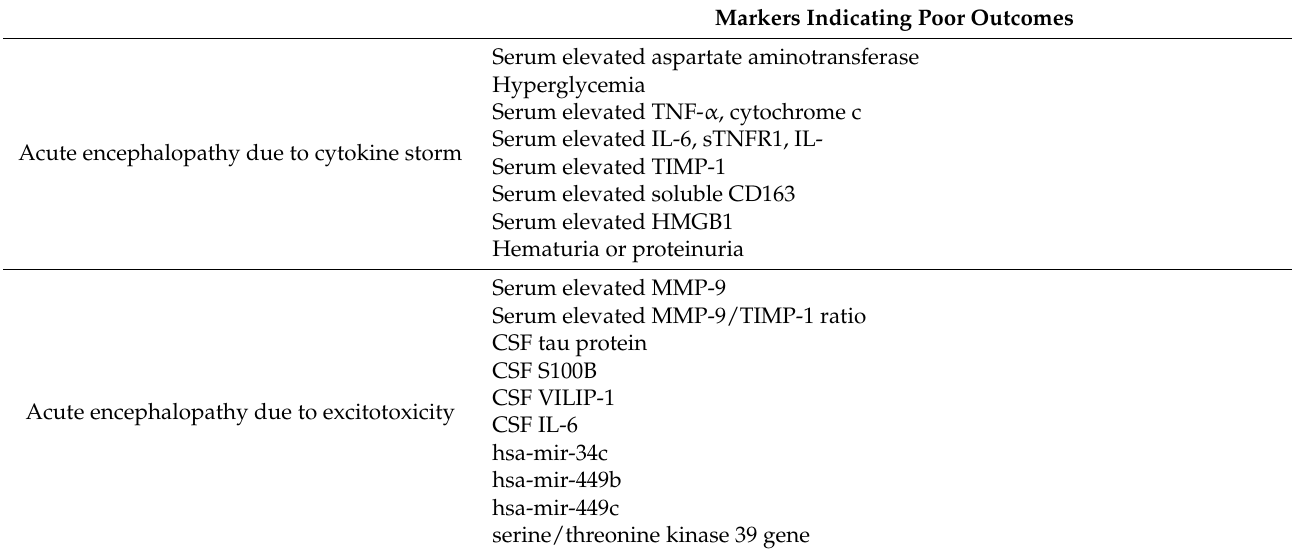
Table 3. Diagnostic markers for acute encephalopathy. Markers Indicating Poor